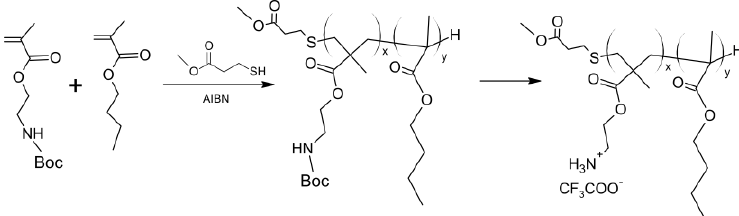
Figure 13. Synthesis of amphiphilic polymethacrylates with antibacterial properties – based on [327].